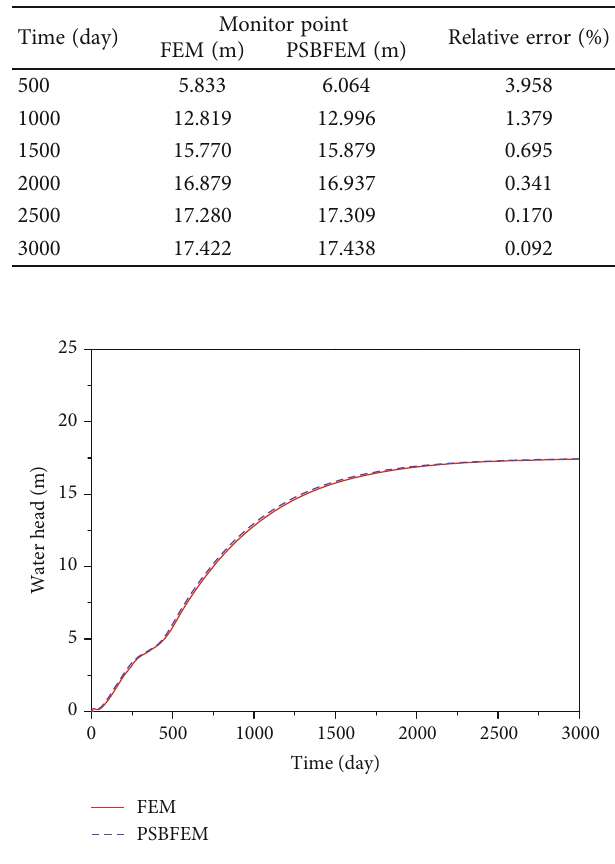
Figure 16: Comparison of the FEM and PSBFEM for the water head history of the monitor